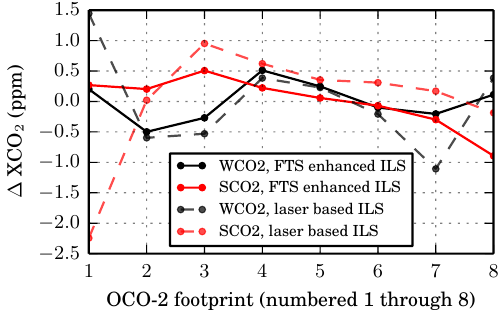
Figure 7. Footprint differences in retrieved CO 2 columns using the strong and weak bands from OCO-2 TVAC data acquired on 21 April 2012.